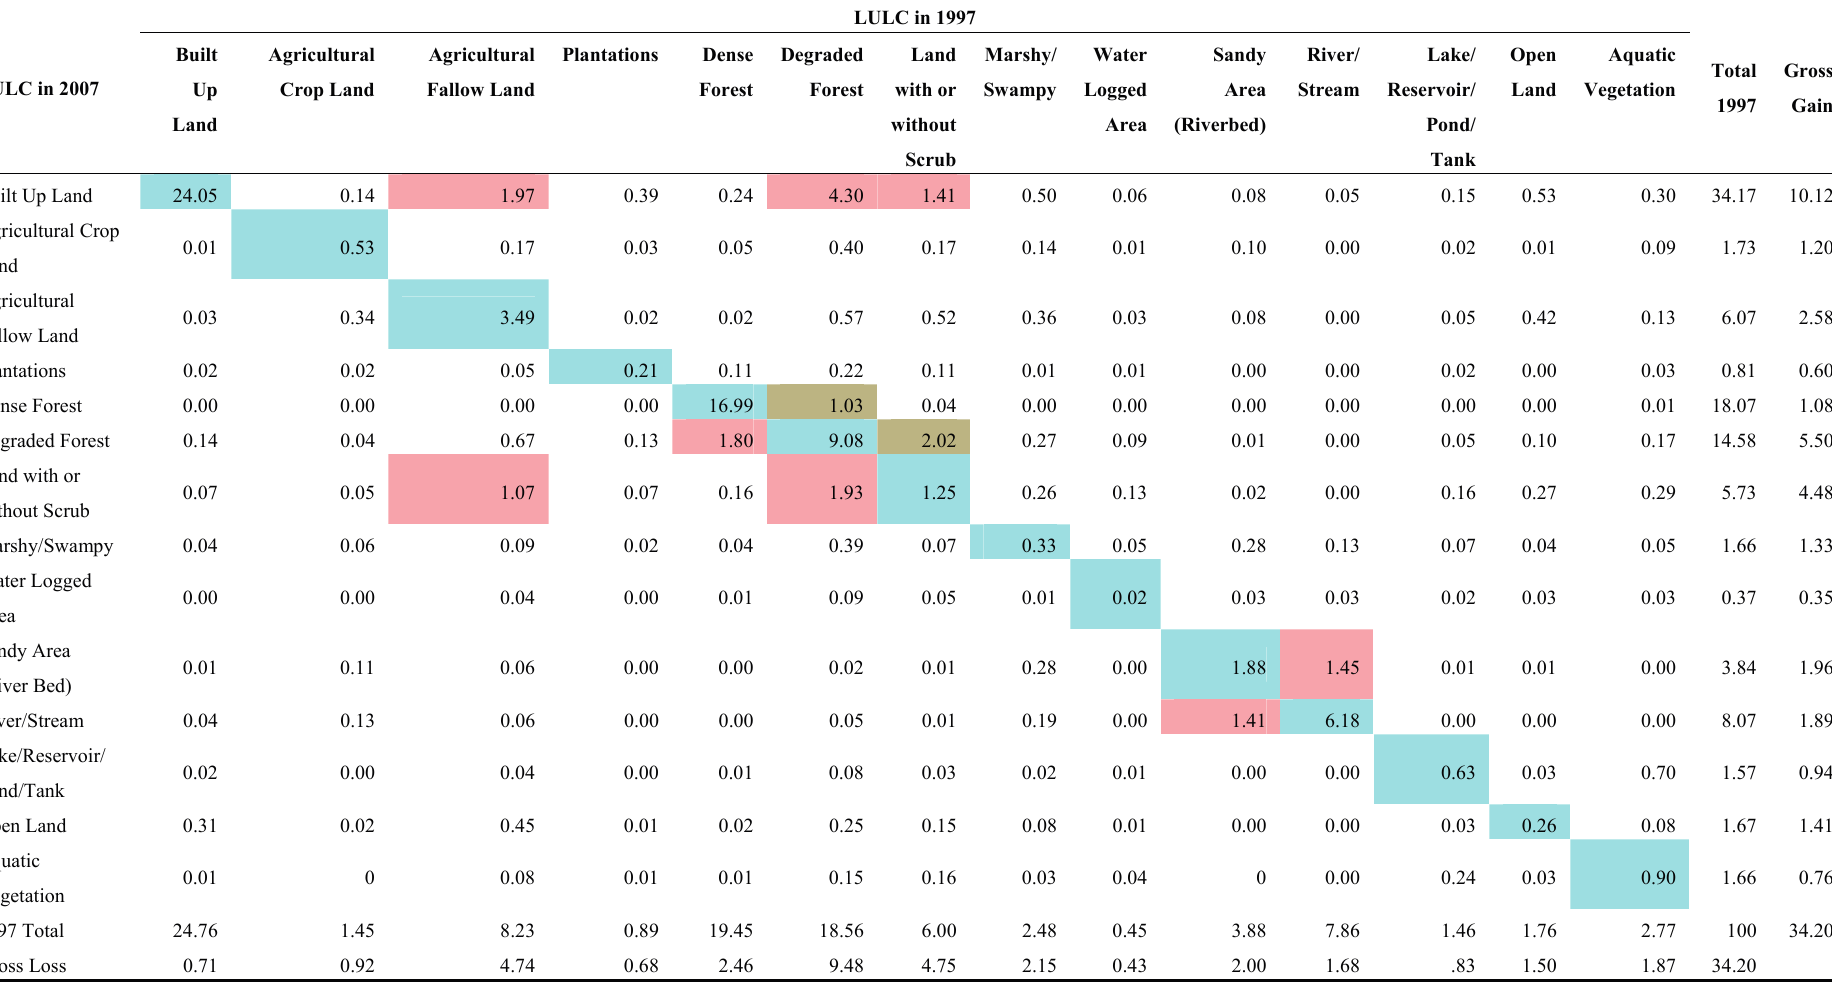
Table 8. Losses and gains, respectively. Light sky shows persistence 1 of categories 2, while pink and ash colours shows major changes (in between